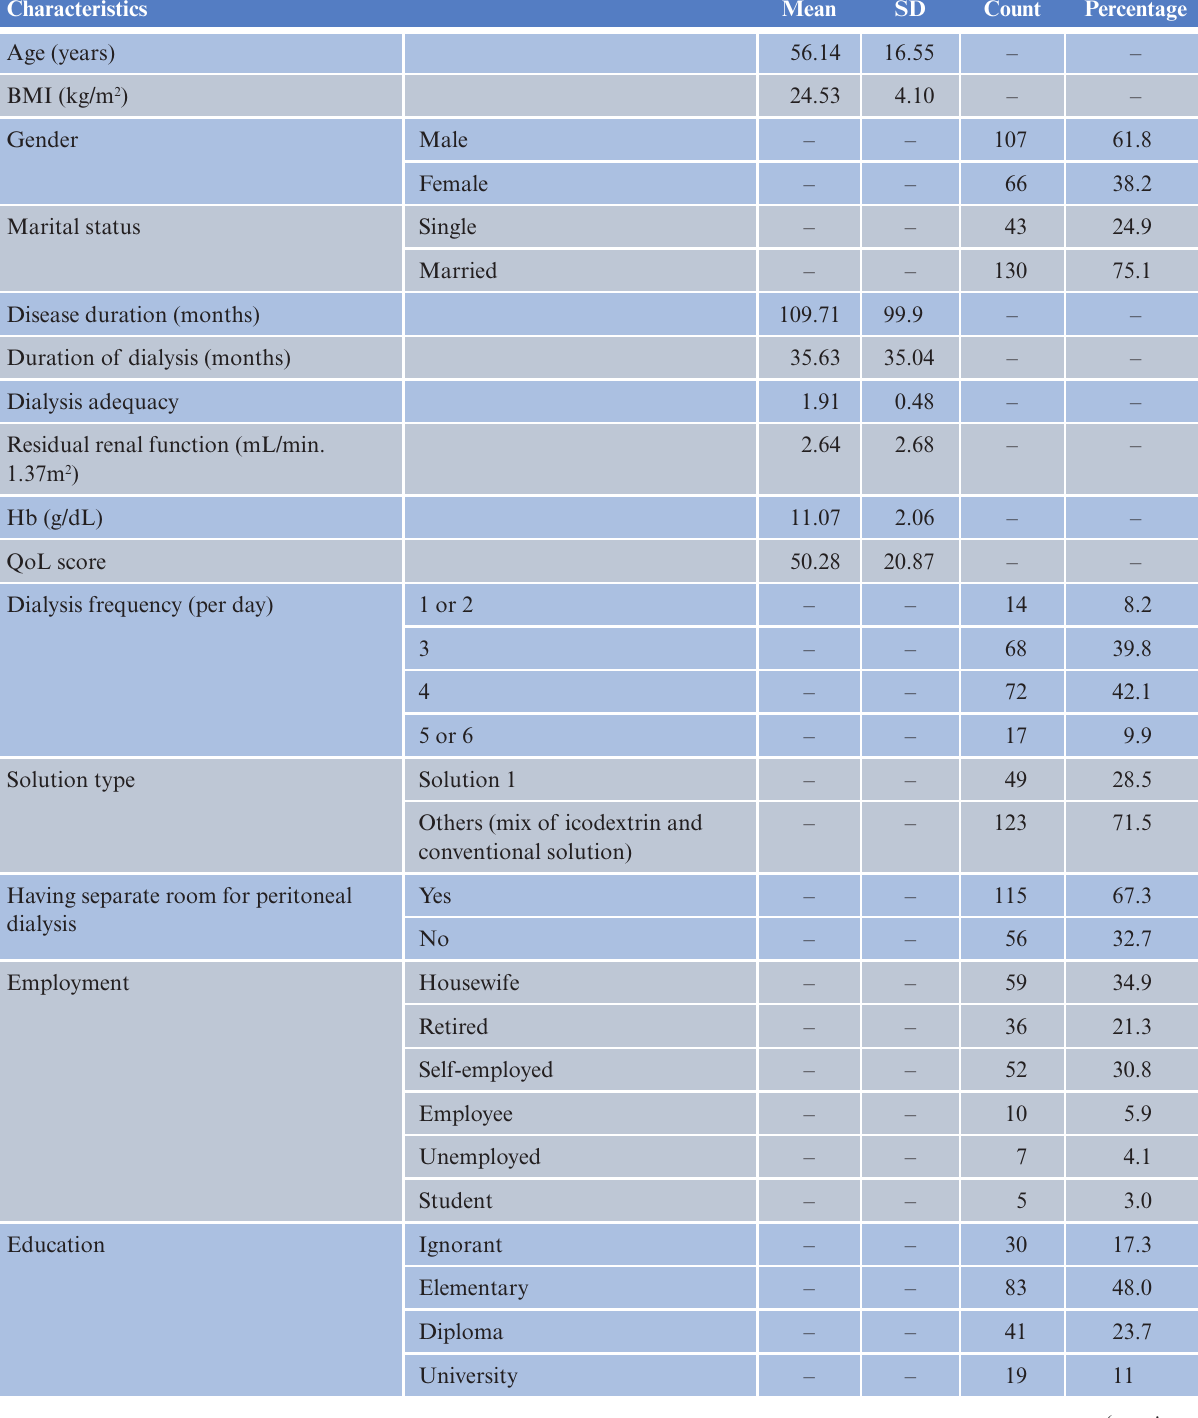
Table 1: Demographic and dialysis-associated characteristics of